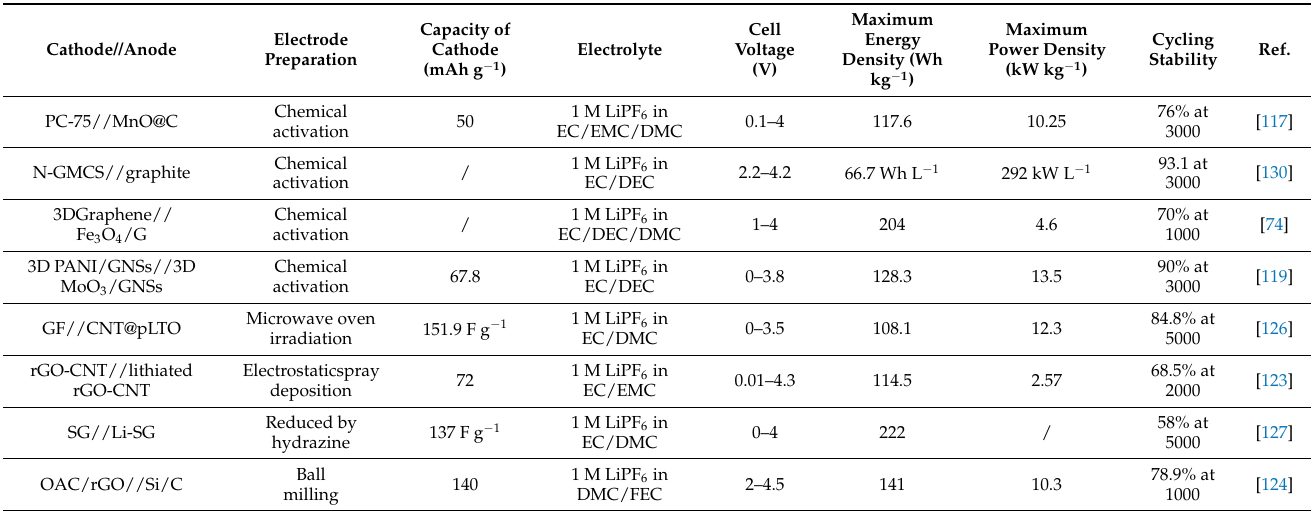
Table 4. Properties of cathodes using graphene-based 3D composites and the performances of